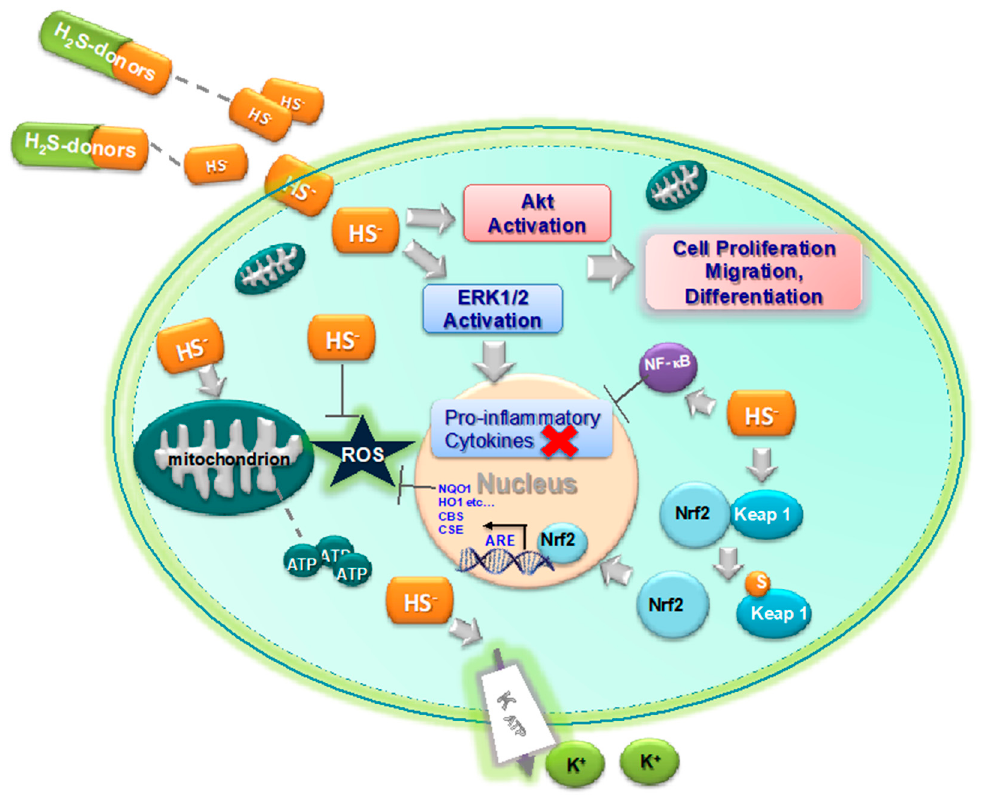
Figure 3. Biological anti-inflammatory e ff ects of H 2 S. H 2 S exerts an anti-inflammatory e ff ect via di ff erent biologic e ff ects: direct and indirect reducing action (Nrf2, ARE activation), a regulatory e ff ect on the immune system via NF-kB interaction, interference with rolling and migration of circulating cells, inhibition of enzymes involved in the inflammatory signaling (protein tyrosine phosphatases (PTPs), PDEs). H 2 S induces separation between Nrf2 and Keap1, allowing Nrf2 to enter the nucleus and bind to the ARE gene; furthermore, it modulates in a dose-dependent manner the expression of many cytokine genes, while it obtains an anti-apoptotic e ff ect through Akt activation. H 2 S, through action on ATP-sensitive potassium channels (K ATP ), inhibits the expression of adhesion molecules on the leukocytes (cluster of di ff erentiation (CD)11 / CD18) and endothelium (P-selectin, intracellular adhesion molecule 1